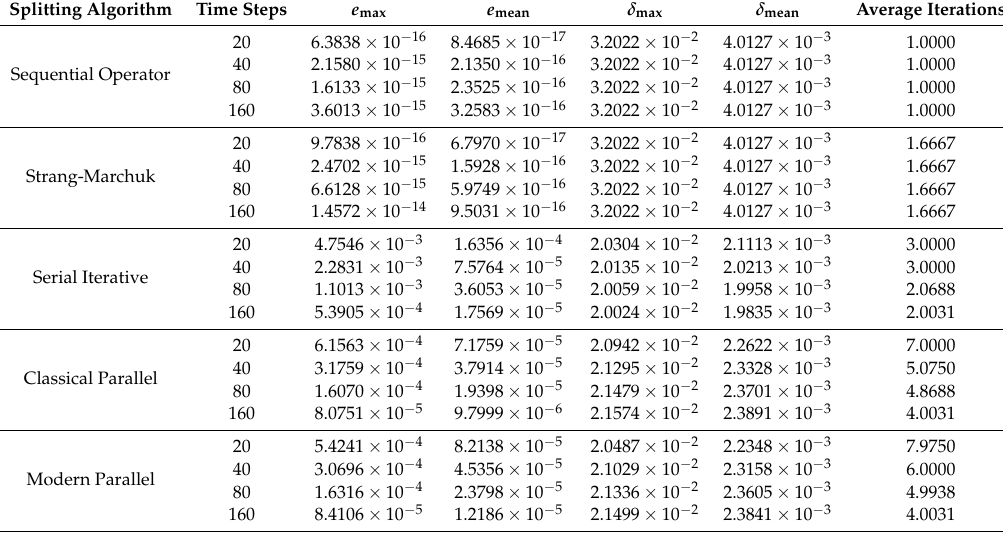
Table 3. Diffusion problem. Results of the directional decomposition using the second order scheme for the spatial discretization, with 10 spatial subintervals and different number of temporal steps.